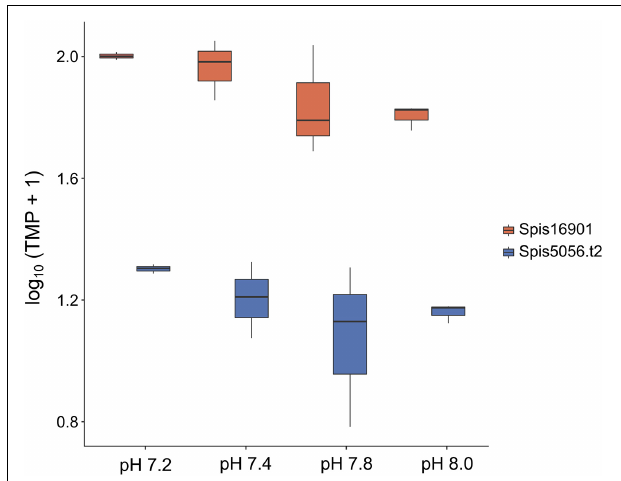
FIGURE 5 | Absolute gene expression (transcripts per million) of two Stylophora pistillata genes encoding for bicarbonate transporter-like proteins across pH treatments. Although expression of these genes was not significantly different among conditions (ANOVA Spis 16901 F = 3.023, p = 0.094, ANOVA Spis 5056 . t 2 F = 1.402, p = 0.311), it followed the order pH 7.2 > 7.4 > 7.8 > 8.0.